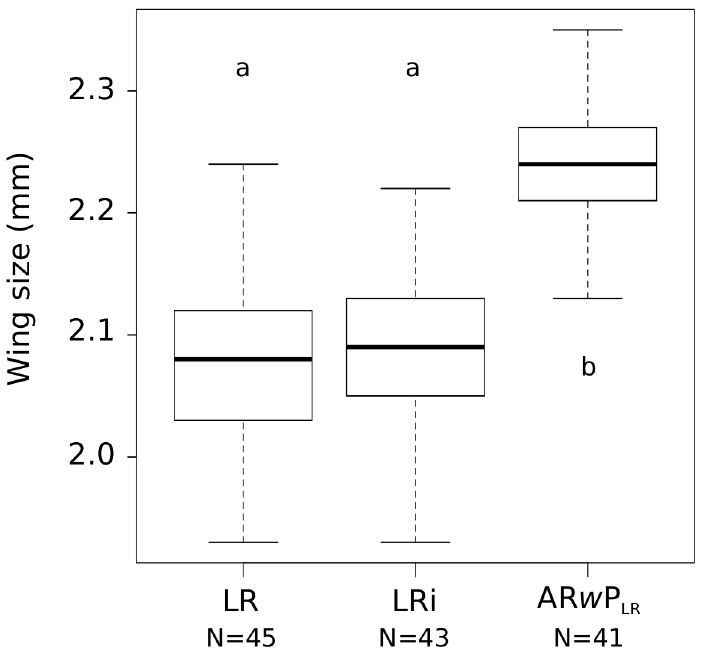
Fig 1. Wing size of males. LR = wild type males, LRi = wild type irradiated males and AR w P LR = incompatible males. N = number of mosquitoes measured. a and b represent statistical group